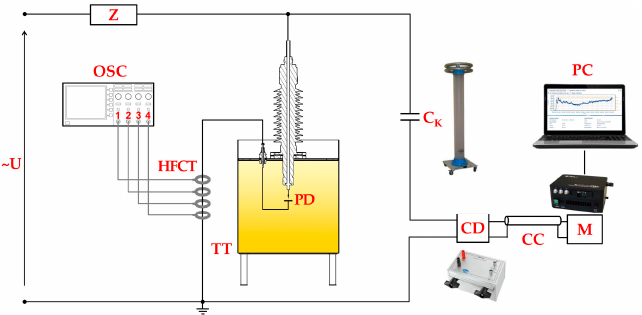
Figure 18. Schematic diagram of the measurement setup for generating partial discharges in oil-paper insulation and assessing the sensitivity of high-frequency PD pulses detection by prototype and commercial HFCT sensors: U = high-voltage supply, Z = short-circuit current limiting resistor, OSC = four-channel oscilloscope, HFCT = high-frequency current transformers under test, TT = oil-filled transformer tank, PD = electrode system for partial discharge generation, C = coupling capacitor, CD = coupling device (measuring impedance), CC = connecting cable, M = conventional partial discharge detector, PC = computer.